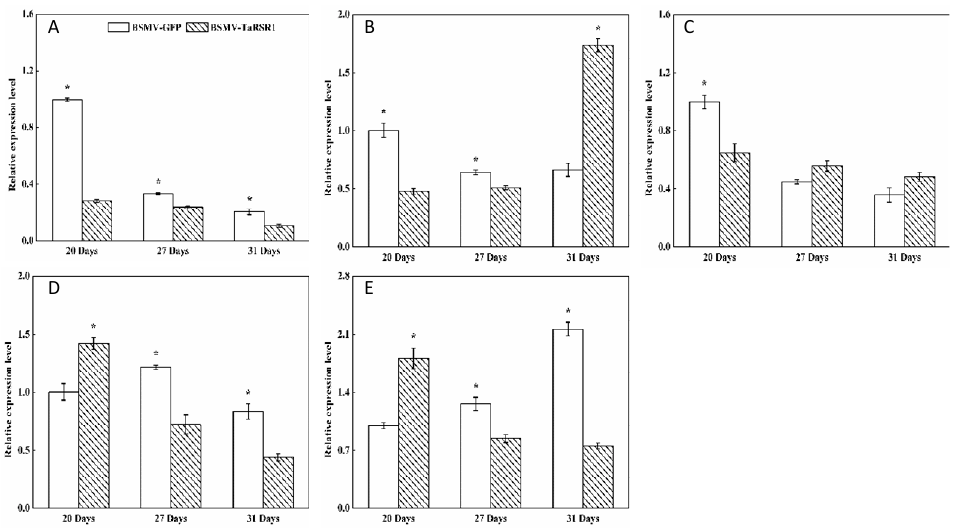
Figure 3. Transcription levels of the AGPase starch synthesis-related enzyme genes in wheat grains of BSMV-TaRSR1-infected and BSMV-GFP-infected spikes at 20, 27 and 31 days after anthesis. Transcription levels were measured by qPCR using Actin gene as internal control. ( A – E ), transcription levels of TaAGPS1-a , TaAGPS1-b , TaAGPS2 , TaAGPL1 and TaAGPL2 genes, respectively . Each value is the mean ± standard deviation of three independent biological replicates. Asterisks indicate significant differences ( p < 0.05).